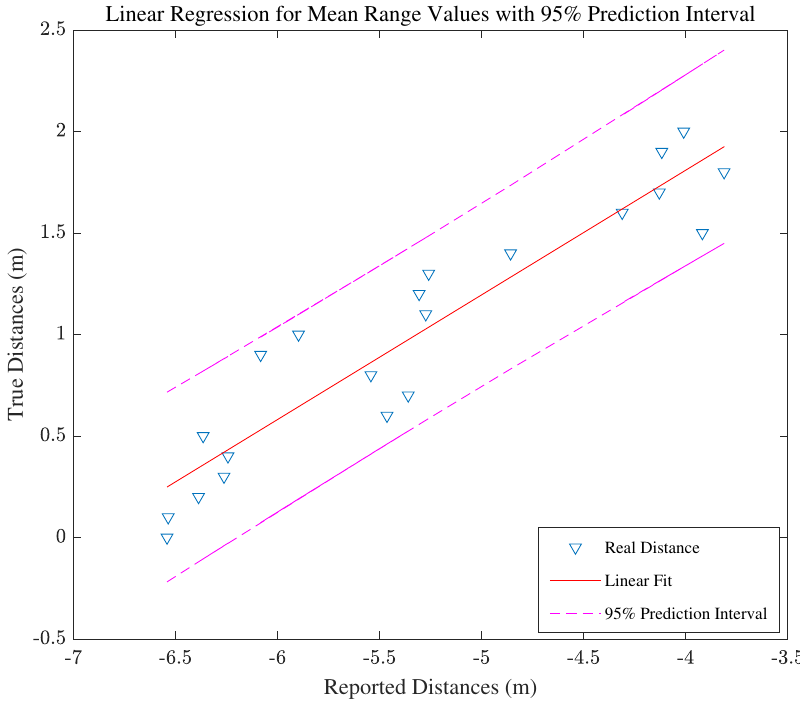
Figure 6. Linear regression for the mean